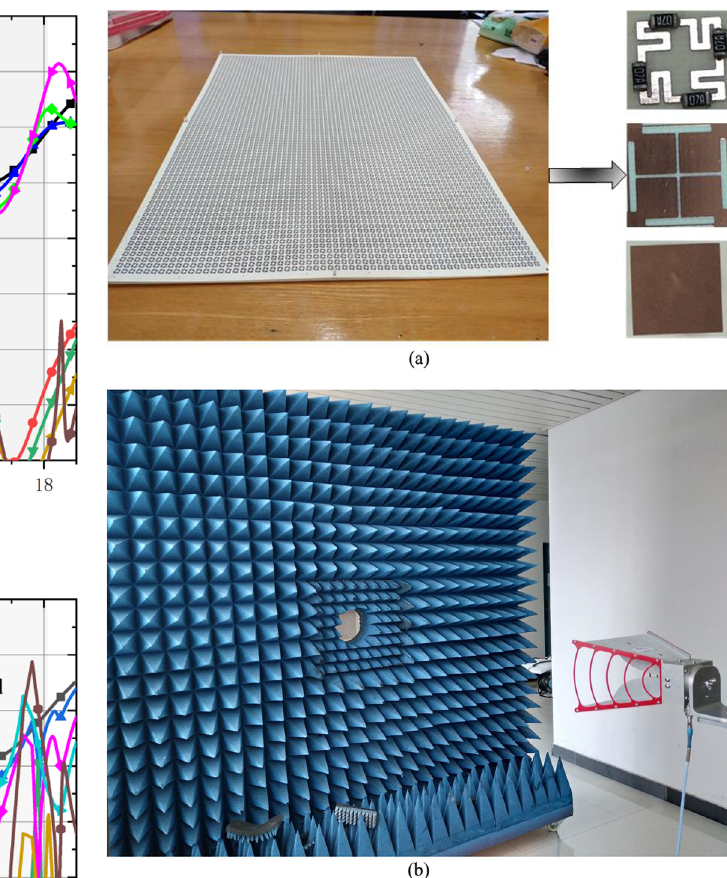
Fig. 8. (a) Prototype of the manufactured FSR. (b) Photograph of the measuring setup.